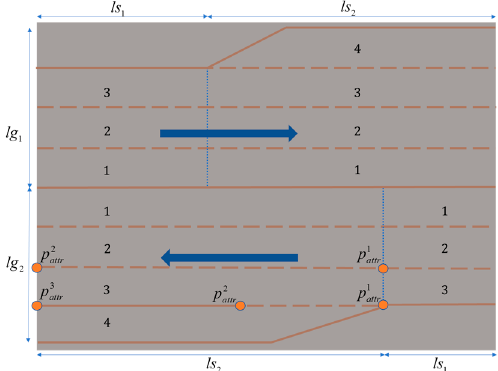
Figure 2. A road used to illustrate the model. The marked numbers are the sequence numbers of lanes.